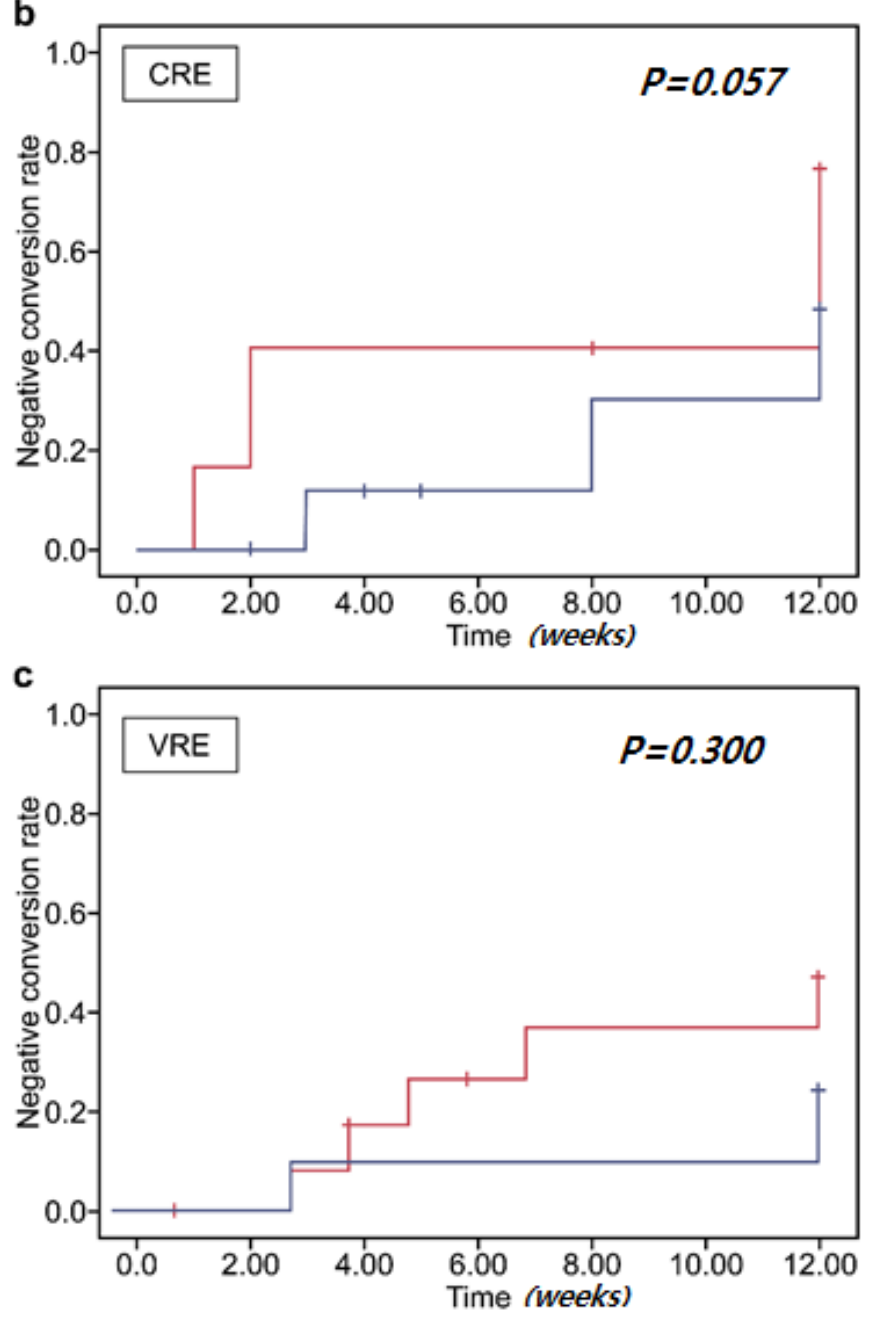
Figure 3. Multidrug-resistant organism (MDRO) clearance rate following fecal microbiota transplantation (FMT). ( a ) Overall cumulative clearance. ( b ) Cumulative clearance of carbapenem-resistant Enterobacteriaceae. ( c ) Cumulative clearance of vancomycin-resistant enterococci.